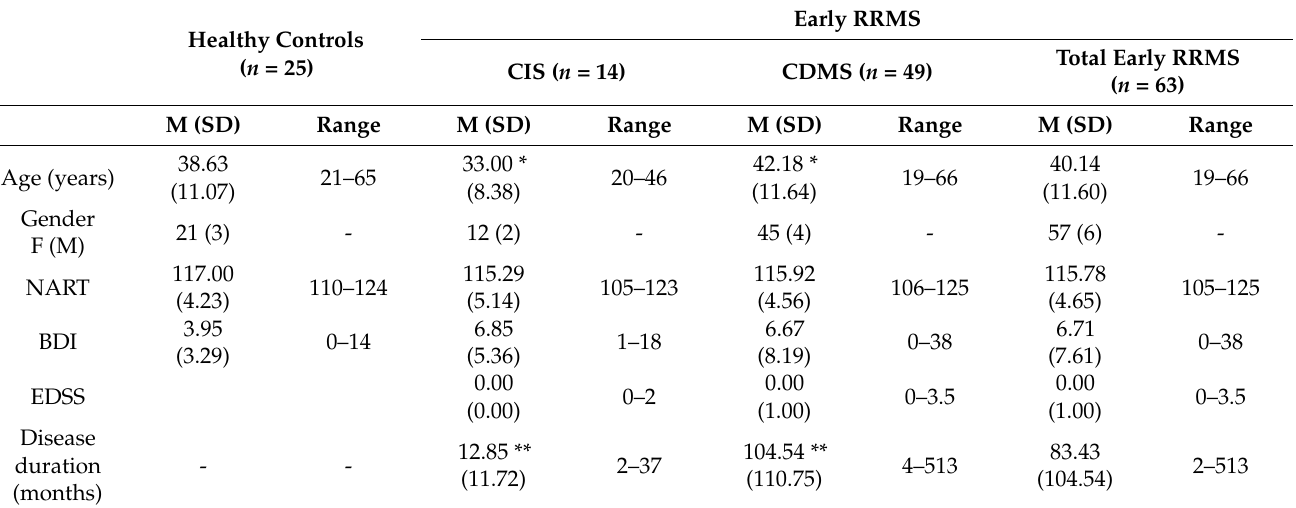
Table 1. Demographic and clinical information for early RRMS and healthy